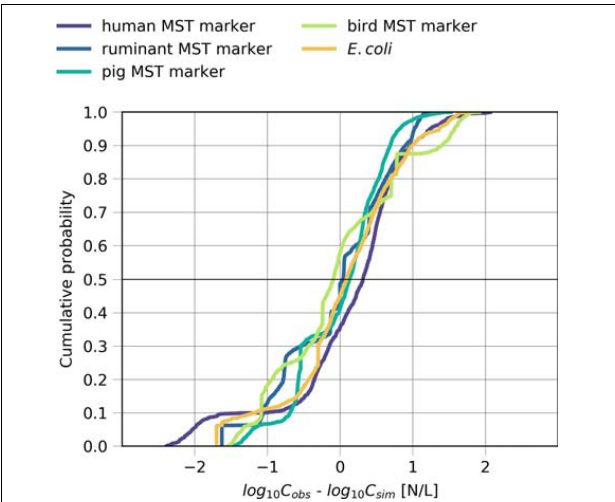
FIGURE 6 | Model performance for the source-targeted microbial fate and transport. Cumulative distribution plot of the difference between the simulated and measured concentrations (log 10 -transformed) of the human, ruminant, pig and bird-associated MST markers and E. coli during days when Danube water discharged into the backwater branch or on rainy days.